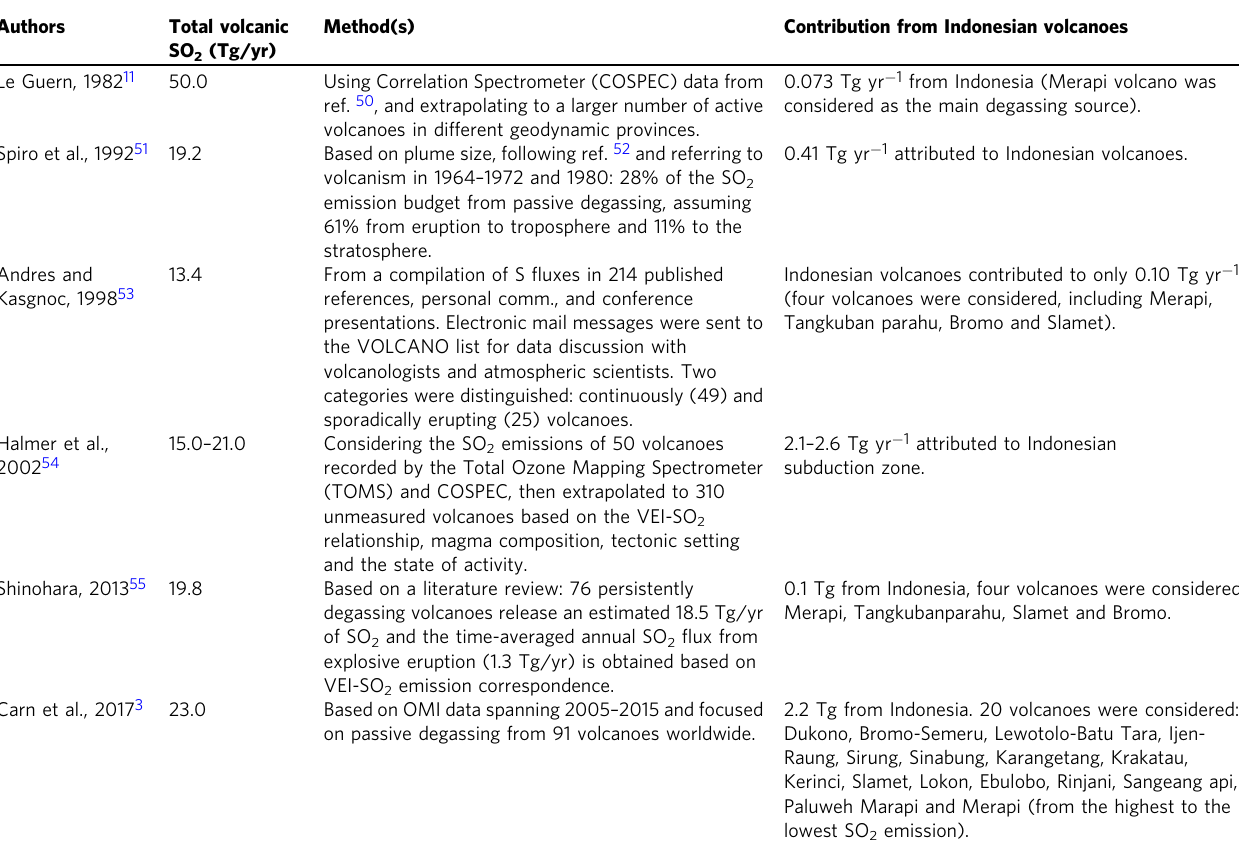
Table 1 Reported global volcanic SO 2 inventories and contribution from Indonesian